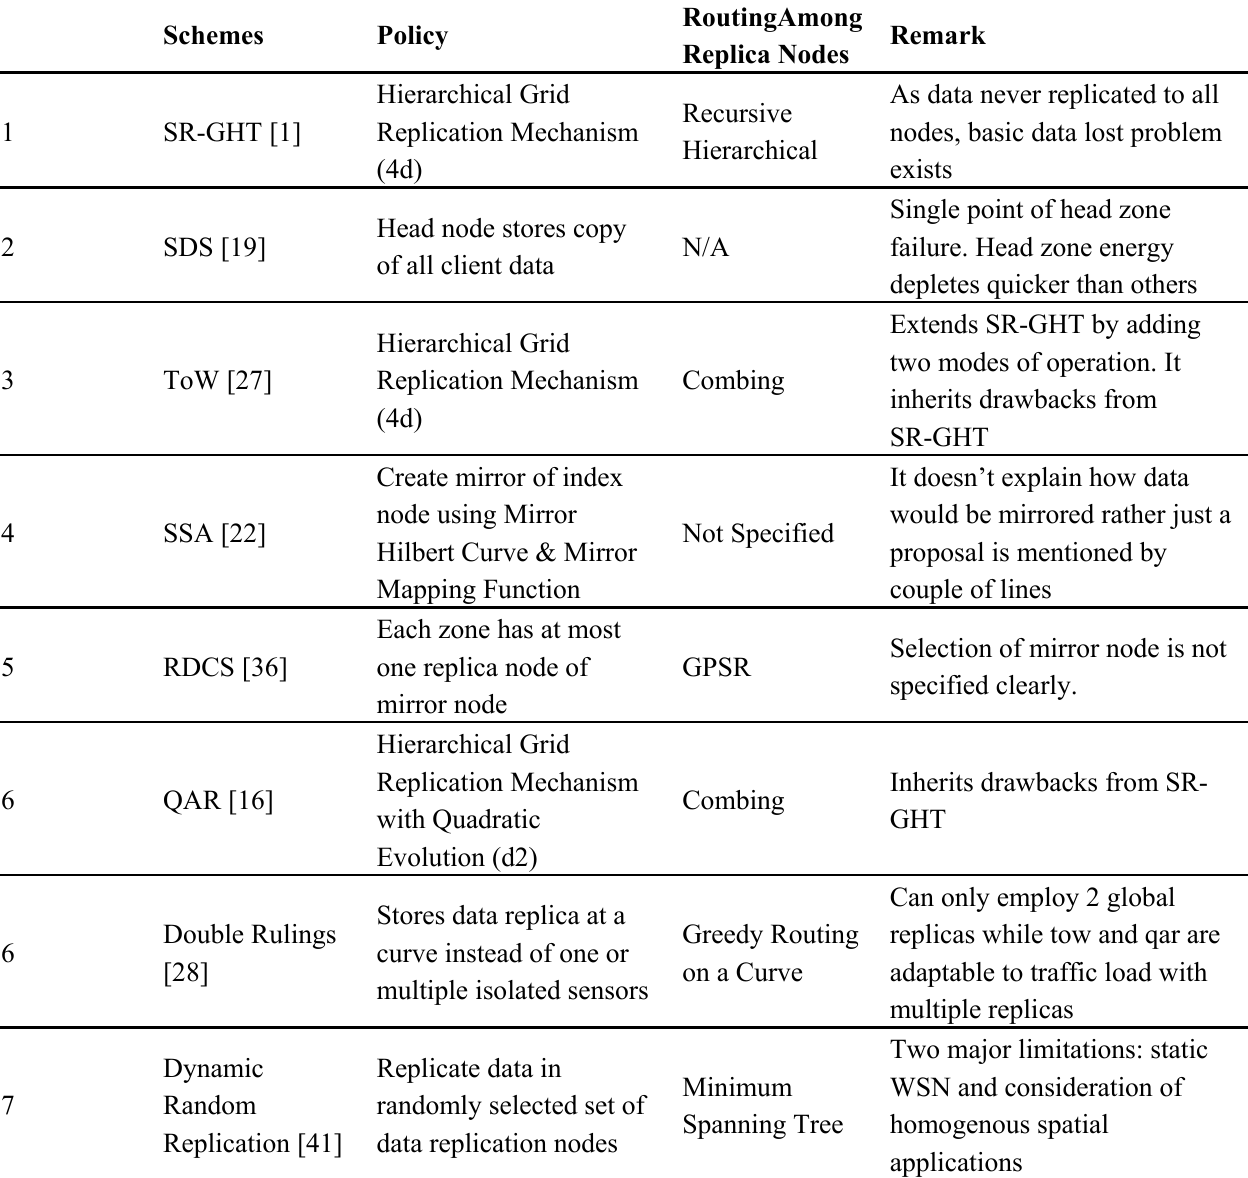
Table 3. Summary of Multi-Replication DCS